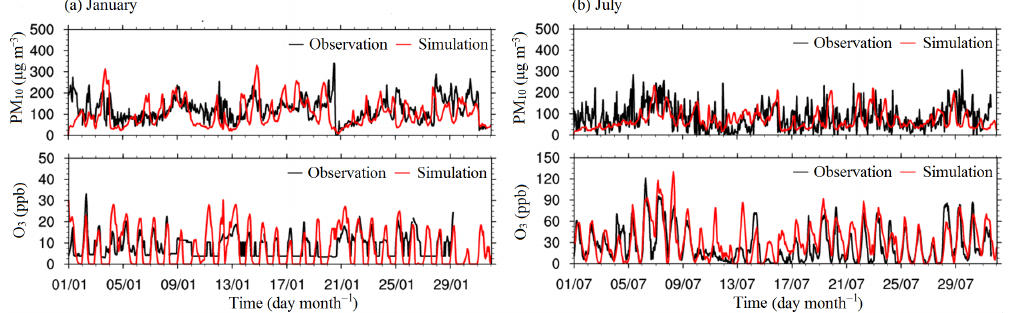
Figure 5. Hourly variations of PM 10 (µgm − 3 ) and O 3 (ppb) from the observation data and the ADDAH simulation results at the CCM monitoring site in Nanjing for January (a) and July (b)